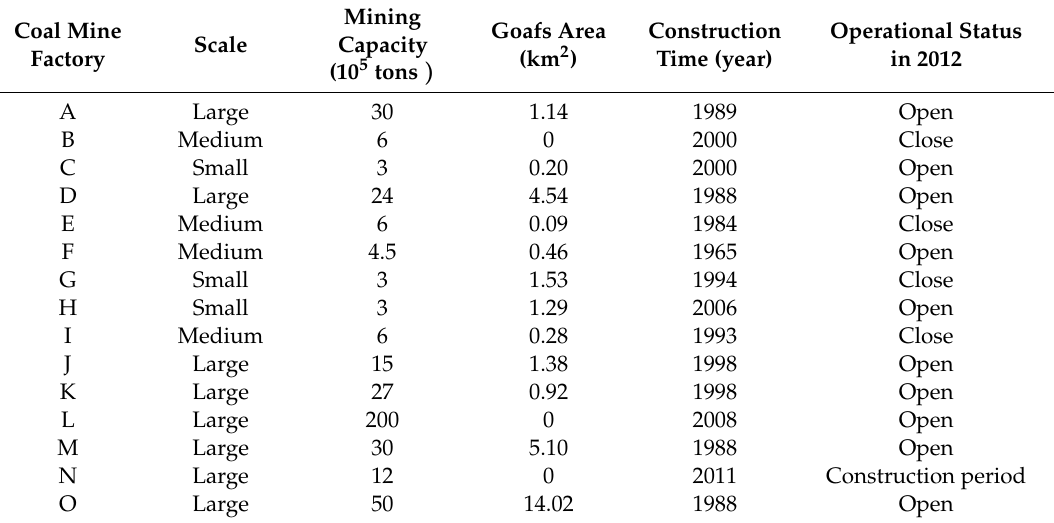
Table 2. Coal mining information collect in